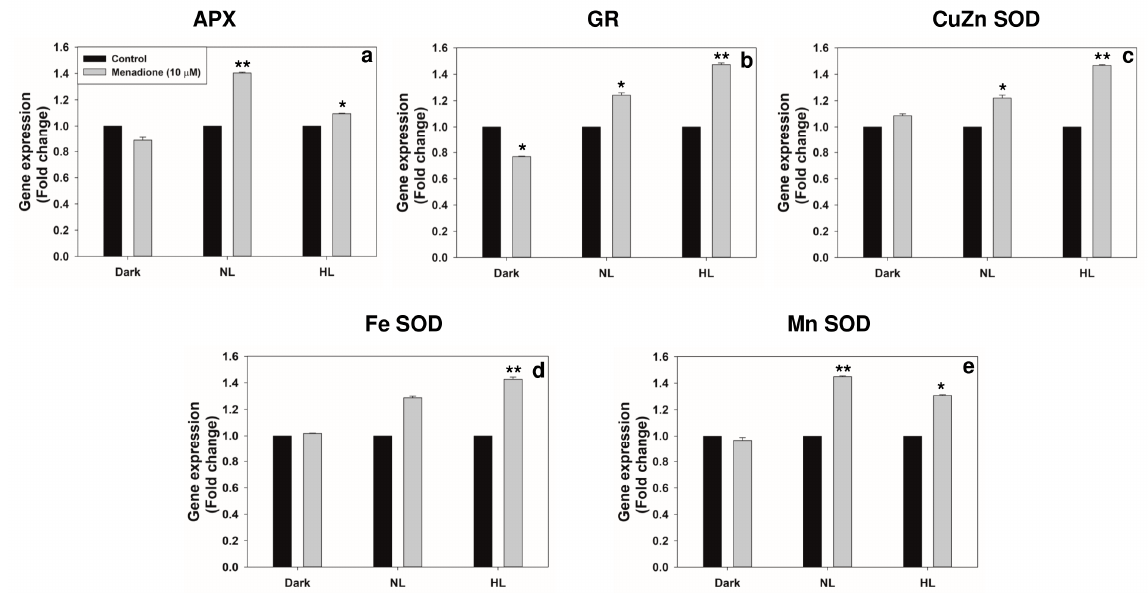
Figure 3. The transcript levels of antioxidant enzymes: ascorbate peroxidase; APX ( a ); glutathione reductase; GR ( b ); copper zinc superoxide dismutase; CuZnSOD ( c ); iron superoxide dismutase; FeSOD ( d ); manganese superoxide dismutase; MnSOD ( e ) on exposure to light in the absence or presence of MD. The expression of genes was represented in fold change after normalization with Actin 2. Each data point is the average of three replicates, and error bars represent ±SE. Asterisks indicate the significance of MD effect compared to the respective control. * p < 0.05 ; ** p < 0.001.